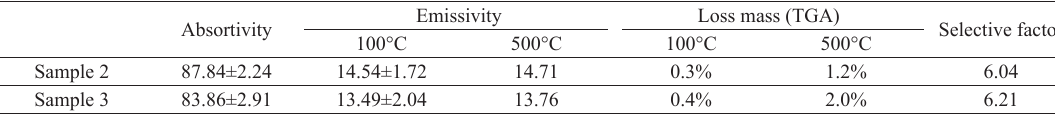
Table 4. Total hemispheric absorptivity and emissivity and selectivity factor of the selected selective